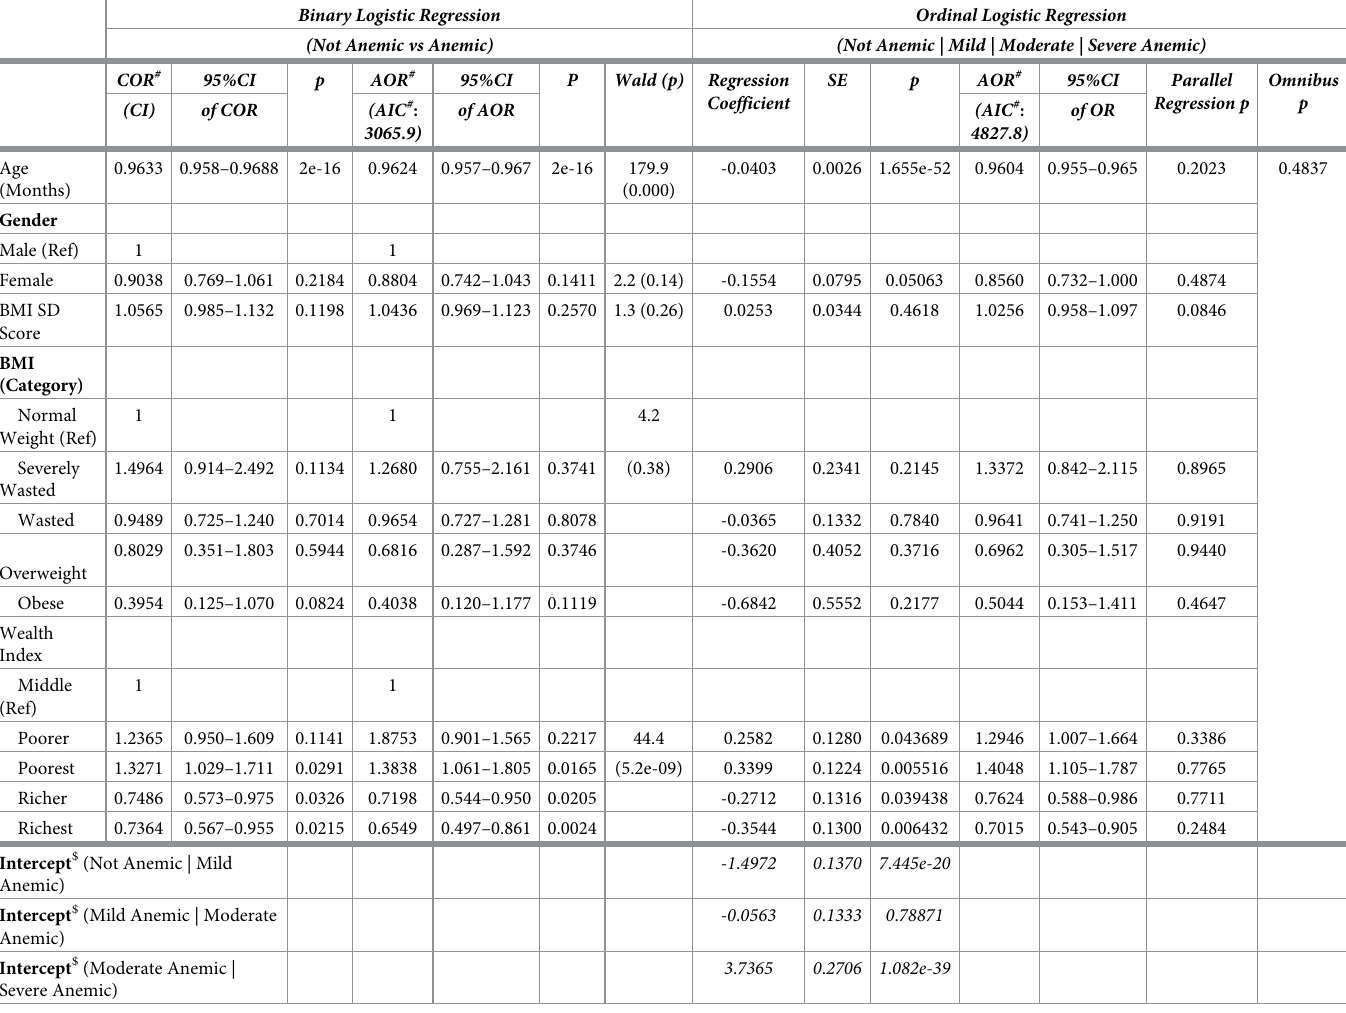
Table 6. Results of multiple binary and ordinal (proportional odd model) logistic regression models of children (n = 2373) using anaemia status as binary and ordered response variable. Binary Logistic